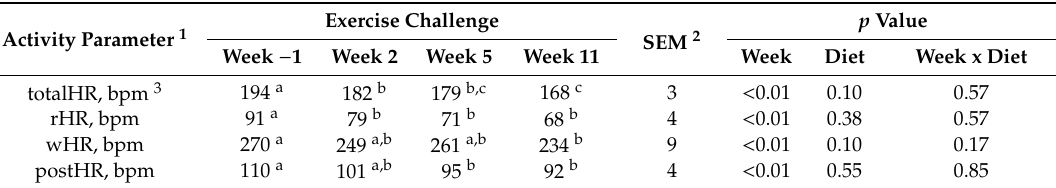
Table 1. Least square mean heart rate (beats per minute) at rest, work, and post-exercise on week − 1, 2, 5, and 11 challenges in sled dogs running at a pace of 15 km / h for 4 km. Activity Parameter